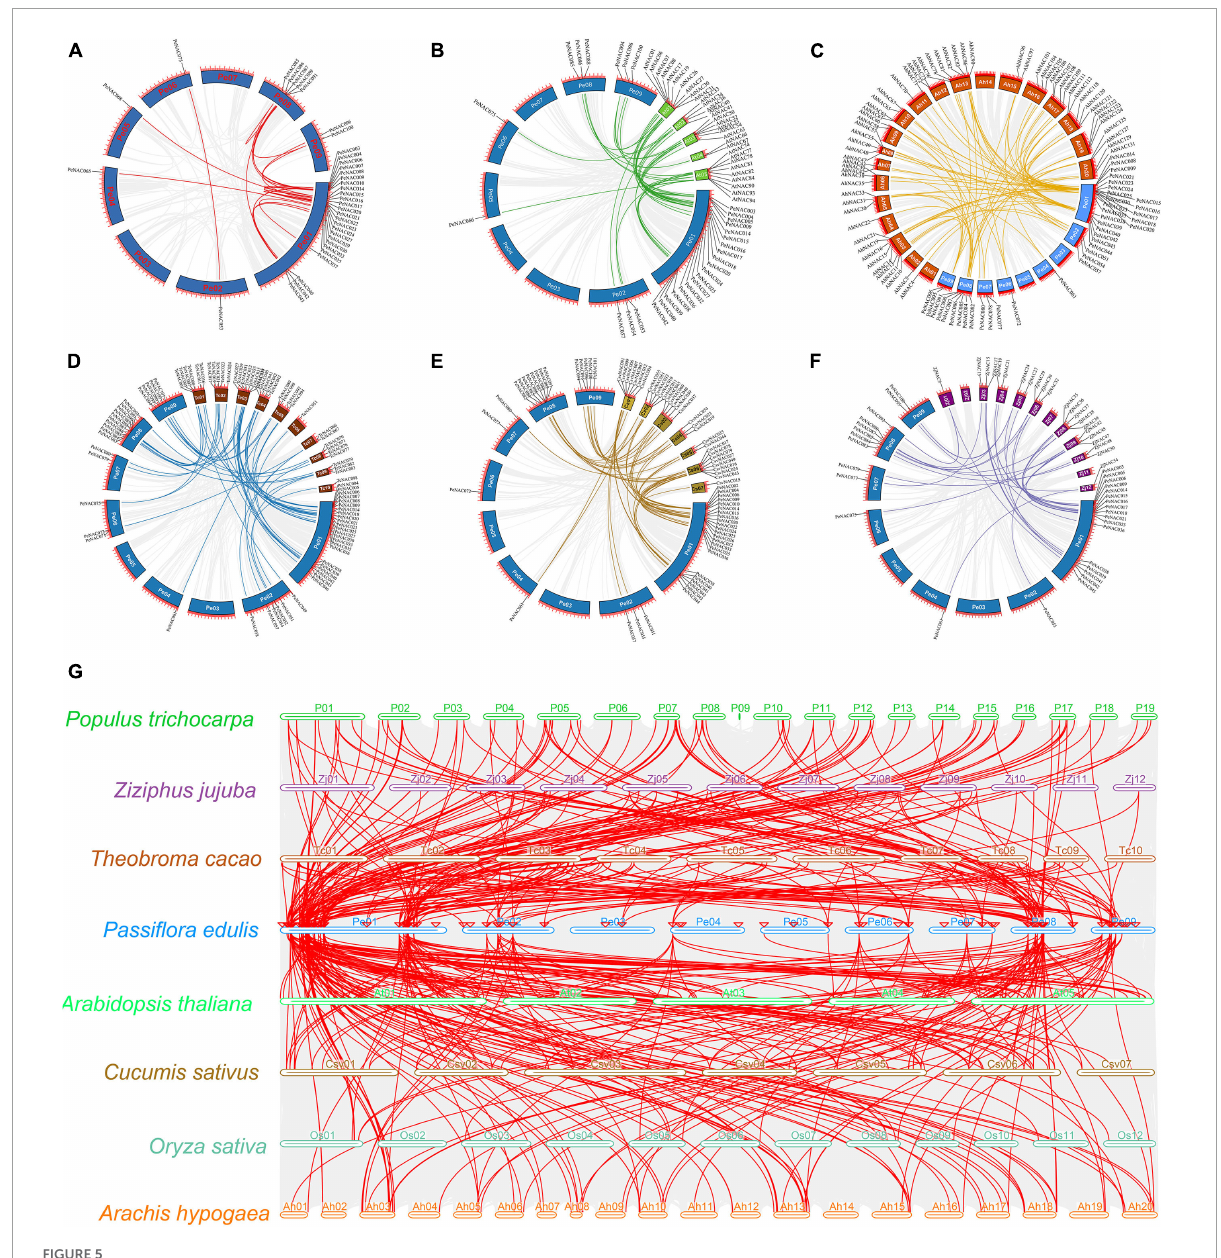
FIGURE5 Circos illustrations of the PeNAC genes duplication and multicollinearity analysis of NAC genes between P. edulis , A. thaliana , P. trichocarpa , Z. jujuba , T. cacao , C. sativus , O. sativa , and A. hypogaea . (A) Gene duplication of NAC genes in P. edulis , the background gray lines show all syntenic blocks in the passion fruit genome, and the red lines show the segmental or tandem duplication line regions among- PeNAC genes. The approximate location of PeNAC genes is labeled with a short gray line outside the chromosome with gene names. (B–F) Orthologous of P. edulis NAC genes with A. thaliana ( AtNAC ), A. hypogaea ( AhNAC ), T. cacao ( TcNAC ), C. sativa ( CsvNAC ), and Z. jujuba ( ZjNAC ). Chromosomes of P. edulis are presented with Pe01–Pe09, A. thaliana with At01–At05, A. hypogaea with Ah01–Ah20, T. cacao with Tc01–TC10 and Z. jujuba with Zj01–Zj12. The background gray lines show all the syntenic blocks genomes of different species, five colors lines represented the syntenic between P. edulis and other species NAC genes. (G) Multicollinearity analysis of NAC genes between P. edulis , A. thaliana , P. trichocarpa , Z. jujuba , T. cacao , C. sativus , O. sativa, and A. hypogaea species, the gray lines in the background represent the collinear blocks within P. edulis and other species genomes.